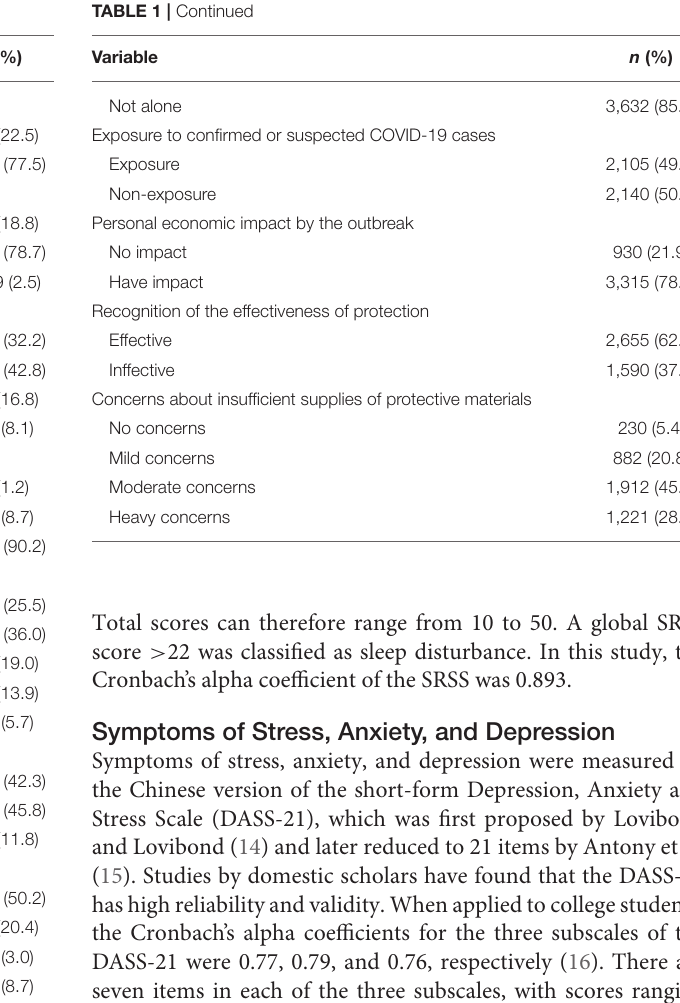
TABLE 1 | Demographics and characteristics of the study